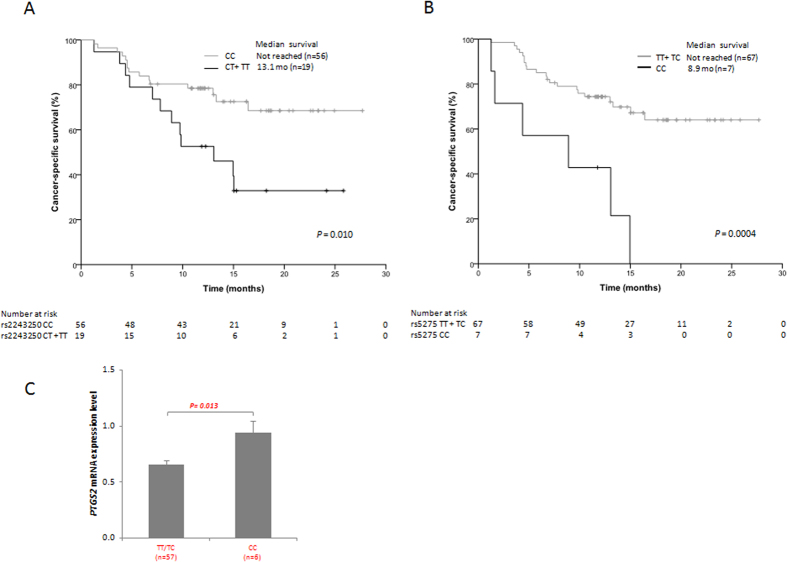
Association of single nucleotide polymorphism rs2243250 (IL4) (A) and rs5275 (PTGS2) (B) with cancer-specific survival in metastatic renal cell carcinoma patients treated with sunitinib. Correlation between PTGS2 mRNA expression levels according to rs5275 genotypes (C). Gene expression was determined in patients carrying T allele (TT/TC) or homozygous for C allele. There is a significant difference between the T carriers and CC genotype (P = 0.013).